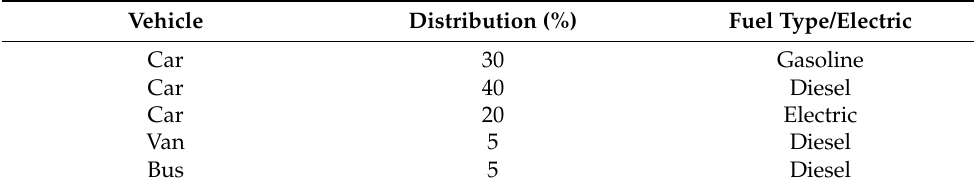
Table 2. Vehicle distribution and fuel type used.